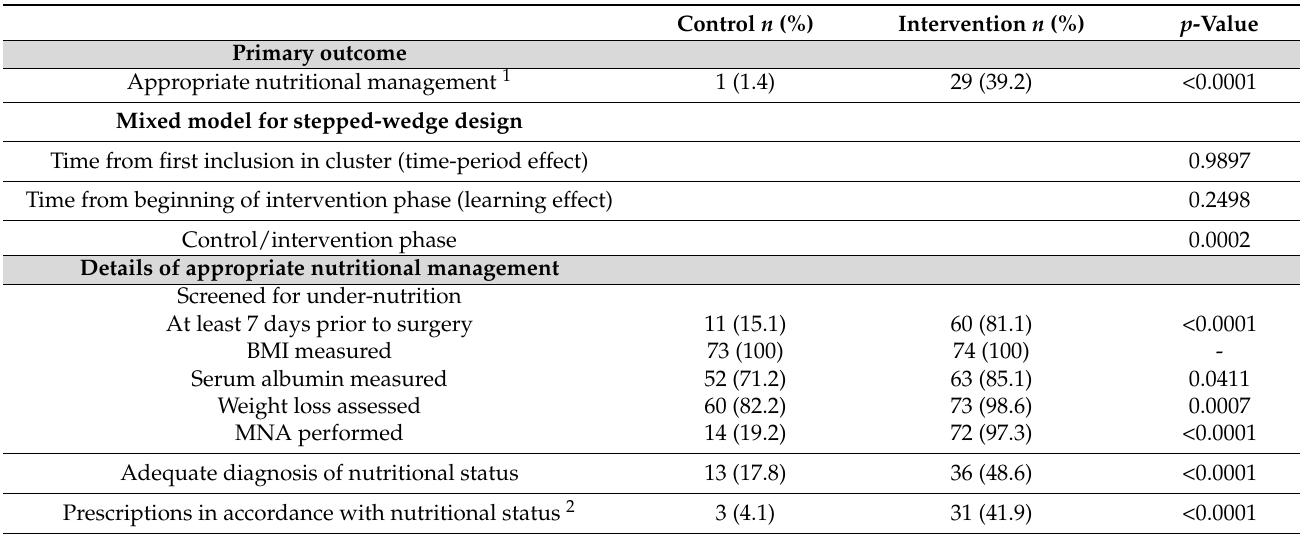
Table 3. Results of the primary outcome and details of its